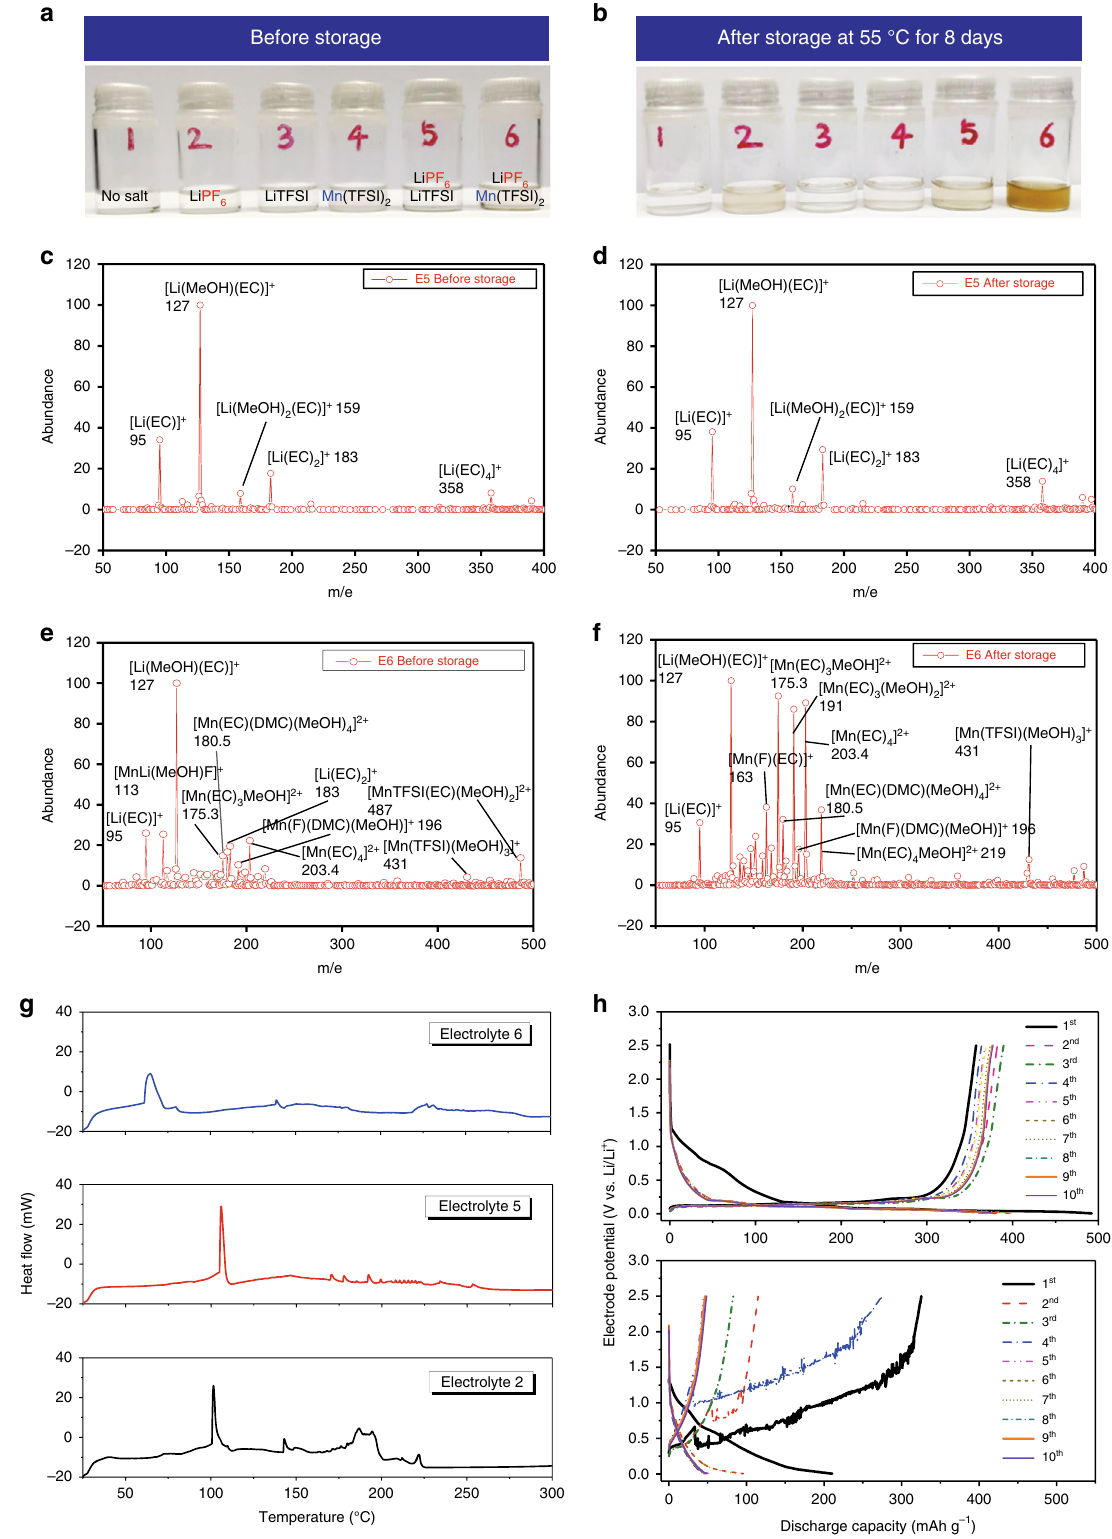
Fig. 2 Presence of Mn 2 + ions triggers thermal decomposition of electrolyte. Electrolyte discoloration before ( a ) and after ( b ) storage at 55 °C for 8 days; ESI-MS characterizations of Electrolytes 5 and 6 before ( c , e ) and after ( d , f ) storage, where methanol was used as diluent solvent; DSC curves of fresh Electrolytes 2, 5, and 6 ( g ); charge/discharge voltage pro fi les of graphite/Li half-cells containing Electrolyte 6 before (upper, h ) and after thermal storage (lower, h ) at a current density of 74.5 mAh g − 1 (0.2 C) between 0.005 to 2.5 V vs. Li/Li